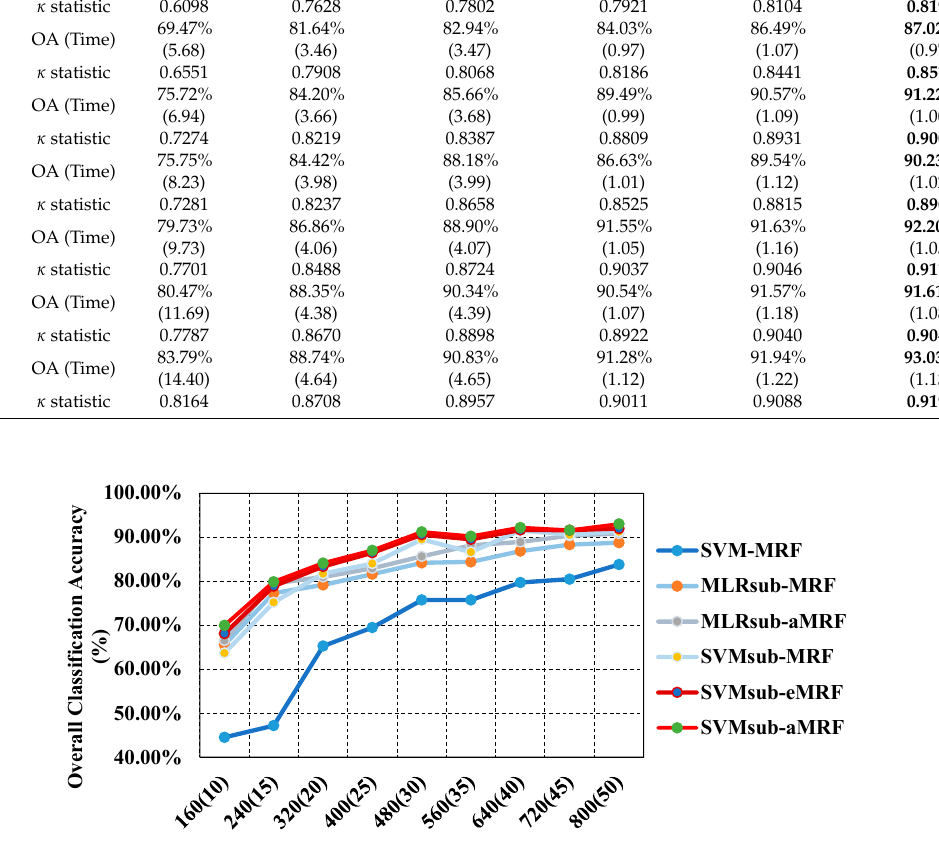
( b ) Figure 7. ( a ) True-color composite of the Reflective Optics Spectrographic Imaging System (ROSIS) Pavia scene; ( b ) Ground reference map containing nine mutually exclusive land-cover classes.